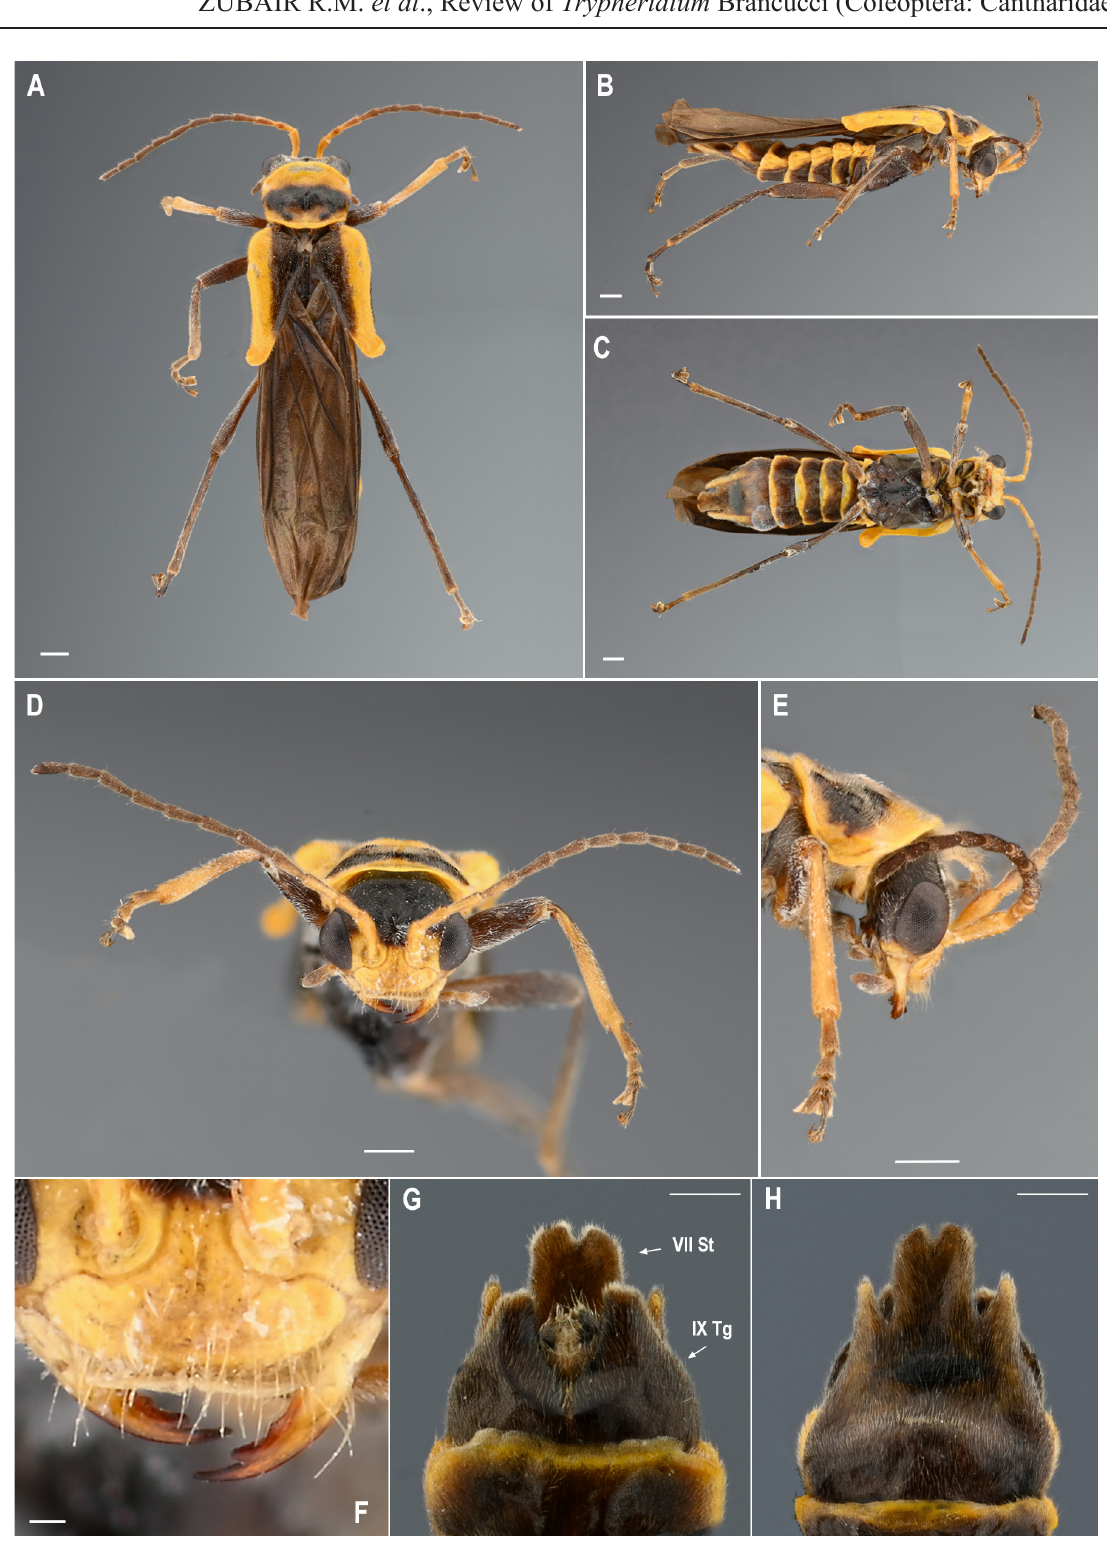
Fig. 4. Trypheridium kashmiricum sp. nov. ♀, paratype (KUIC 0015). A . Habitus, dorsal view. B . Habitus, lateral view. C . Habitus, ventral view. D . Head, front view. E . Head, lateral view. F . Mandibles. G . Terminal segments dorsal view. H . Terminal segments, ventral view. Abbreviations: VII St = sternite VII; IX Tg = tergite IX. Scale bars: A–E, G–H = 0.5 mm; F =